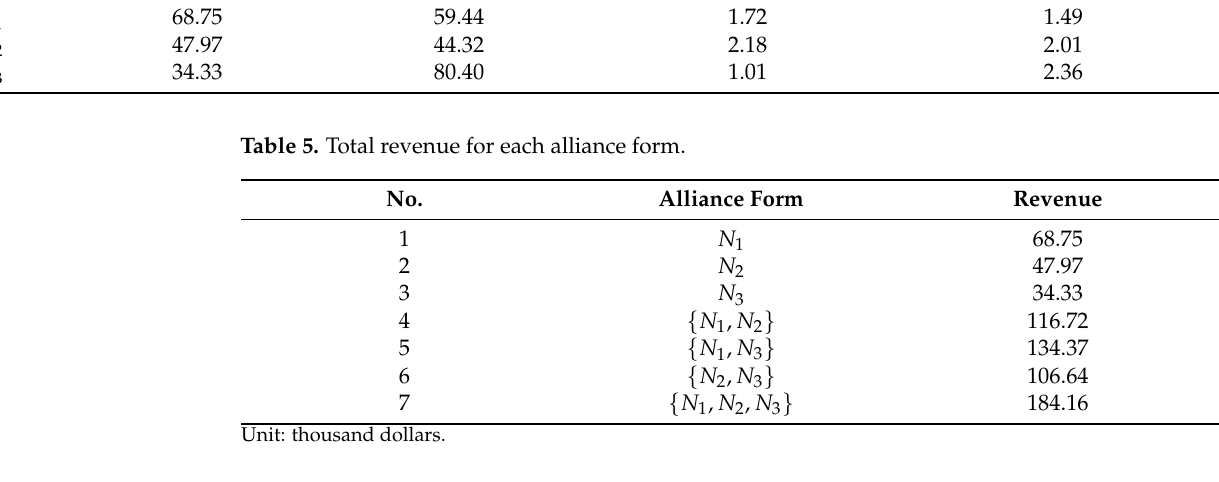
Figure 4. Water rights allocated after optimization.